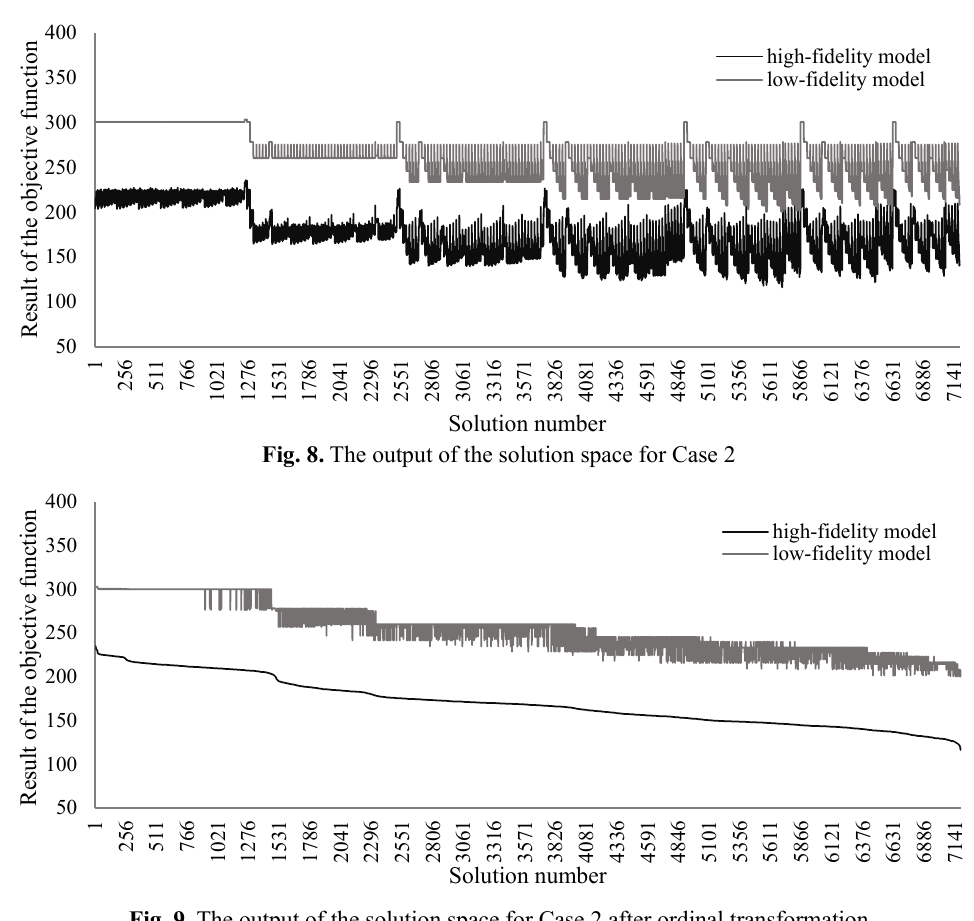
Fig. 9. The output of the solution space for Case 2 after ordinal